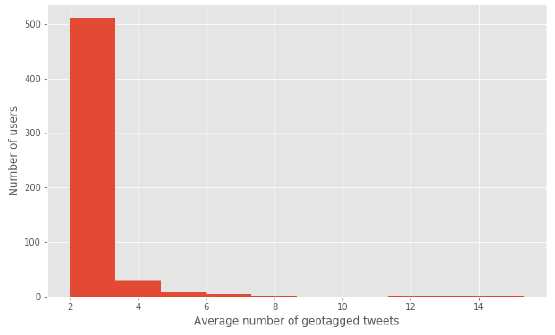
Figure 3. Number of users for each average number of geo-